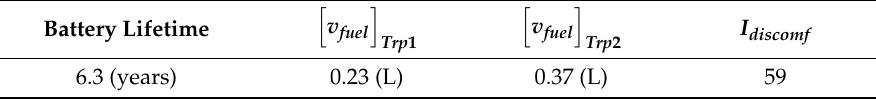
Table 5. Performance measures of the PHEV